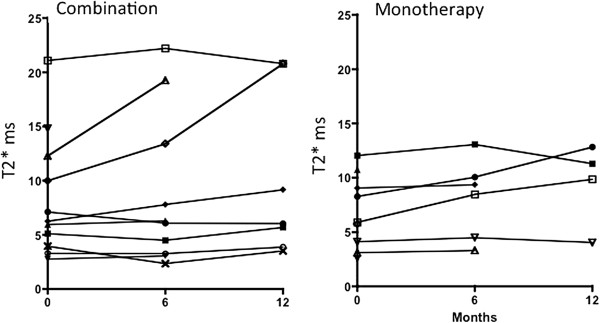
Baseline, 6 and 12 month myocardial T2* values with DFO monotherapy and DFP combination are shown. Myocardial T2* improved in both arms (p = 0.04), with no significant difference between treatments (p = 0.65 for treatment; p = 0.48 for the interaction): improvement with DFP was by 1.5 ms at 6 months and by 1.9 ms at 12 months: with DFP monotherapy this was by 1.1 ms and 1.9 ms respectively.